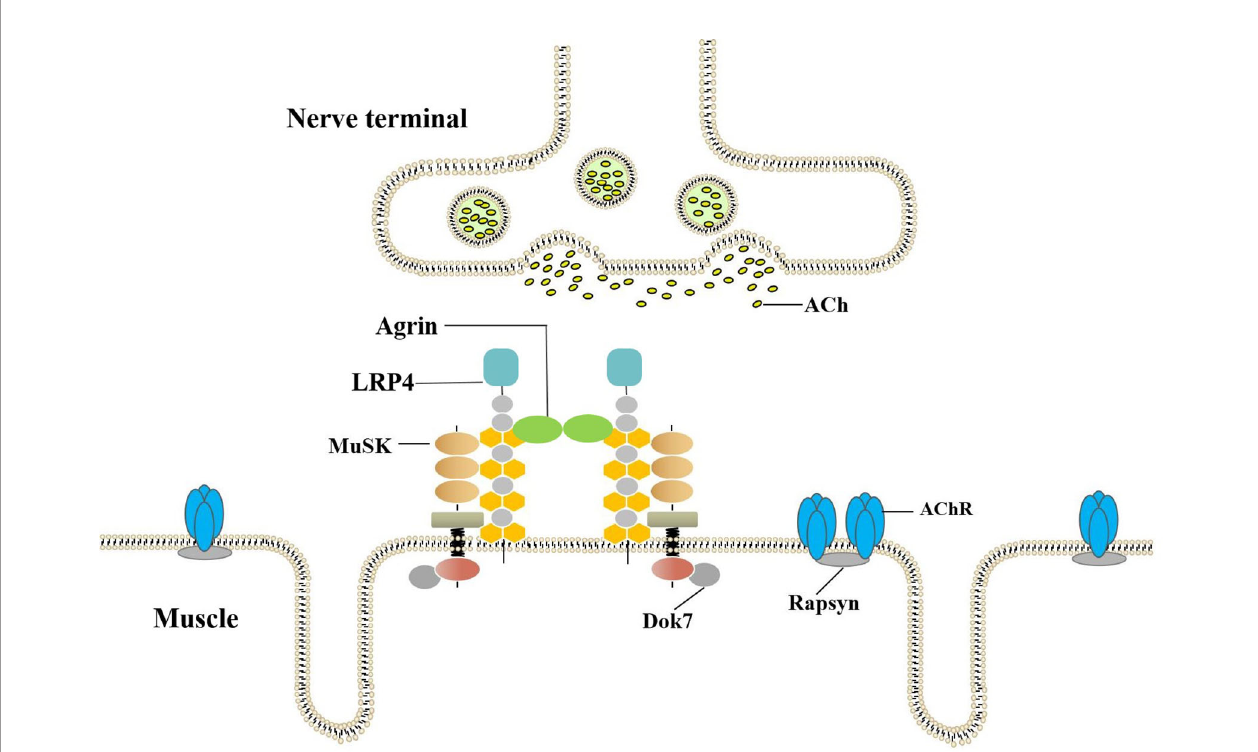
FIGURE 1 | Agrin-LRP4-MuSK-Dok7 pathway for AChR clustering. The combination of Agrin and LRP4 activates MuSK. Recruitment of Dok-7 further enhances MuSK dimerization resulting in the full activation of the MuSK kinase. The MuSK signaling then induces AChR aggregation in